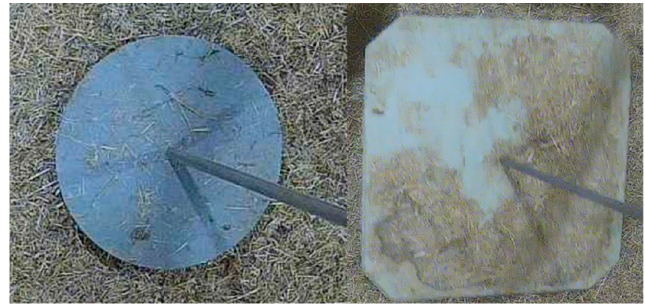
Figure 5. The weighing plates used in the experiment.